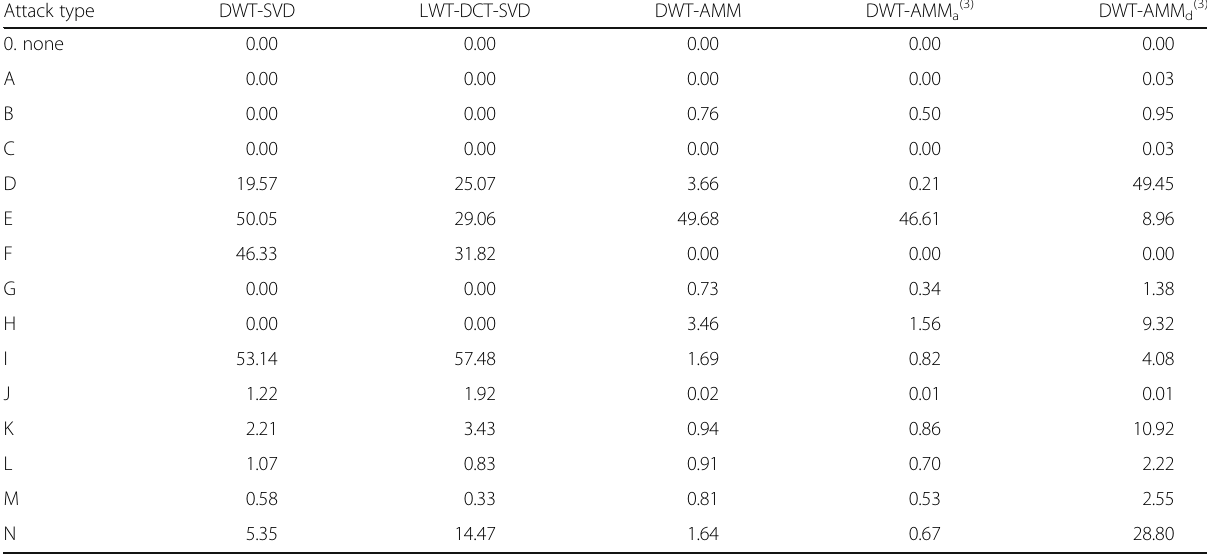
Table 5 Average bit error rates (in percentage) for three compared watermarking methods under various attacks Attack